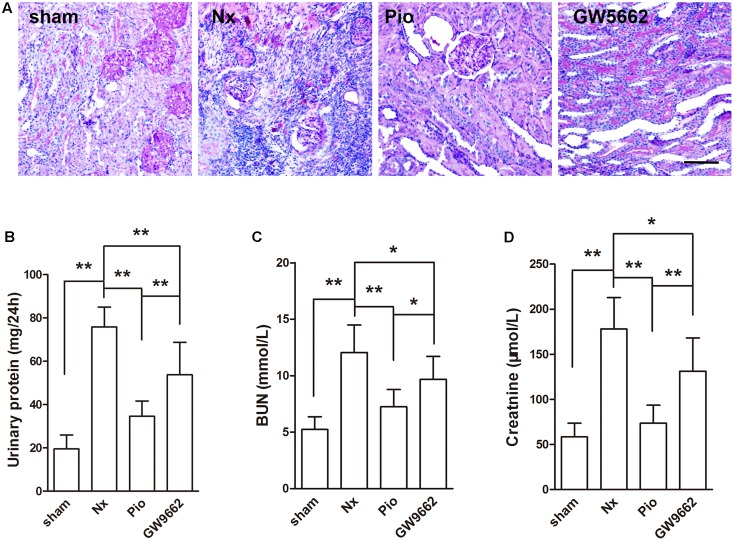
Effects of pioglitazone on renal structure and renal function in Nx rats. (A) PAS staining showed tubular atrophy and tubular dilation in the kidney of Nx rats, and pioglitazone treatment attenuated these injuries. Scale bar: 100 μm (B) Urinary protein excretion rate, (C) blood urea nitrogen (BUN) and (D) plasma creatinine were increased in Nx rats and pioglitazone treatment restored the increase. The therapeutic effect of pioglitazone was inhibited by the PPARγ inhibitor GW9662. n = 6. ∗P < 0.05, ∗∗P < 0.01, compared with the Nx group.